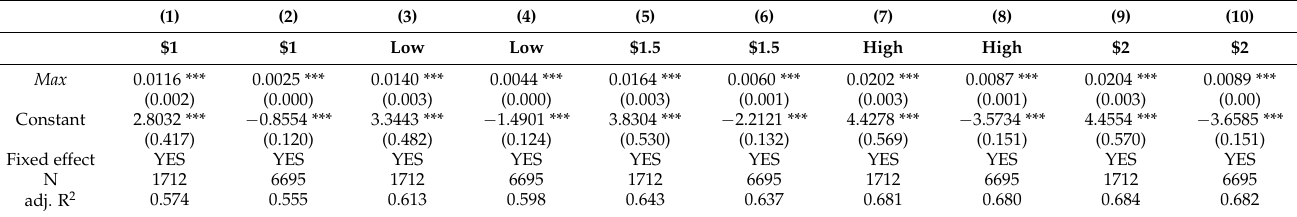
Table 12. Impact of extreme low temperature on poverty vulnerability—altitude.